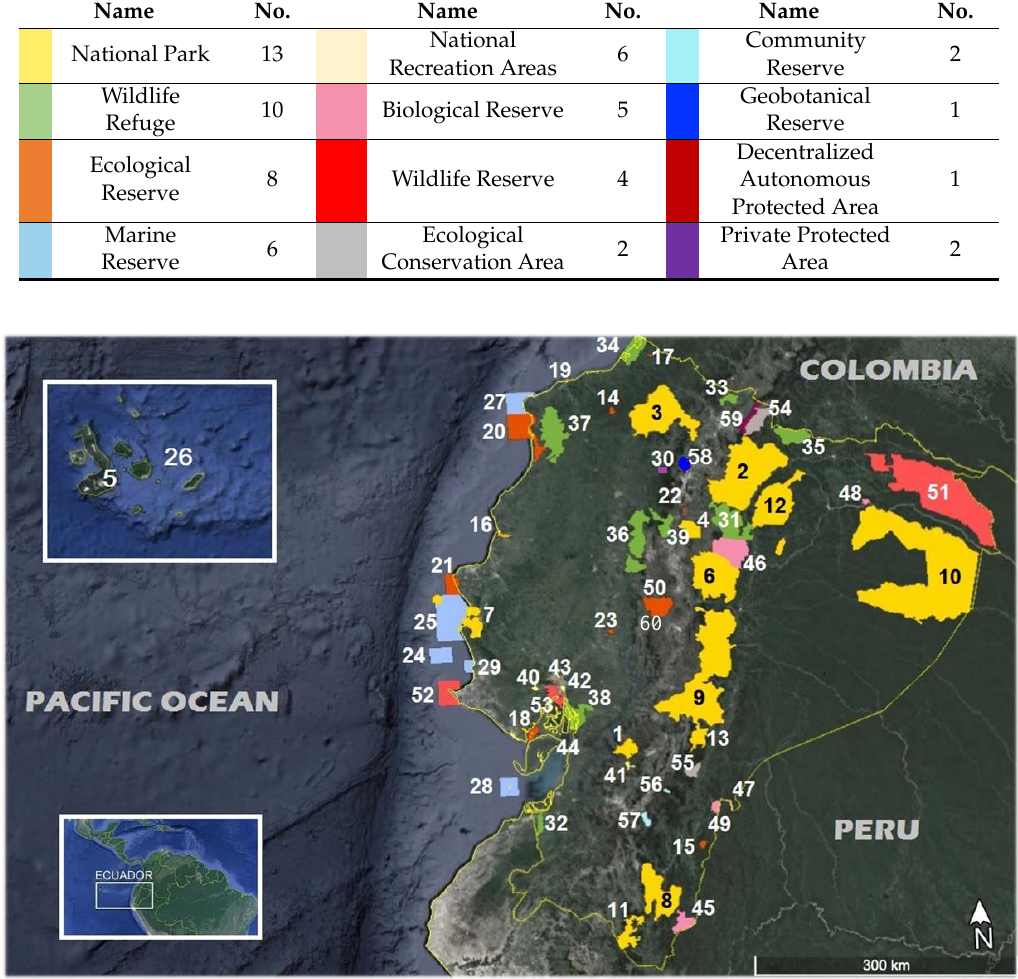
Table 3. National System of Natural Protected Areas (NSNPA) Management Categories.